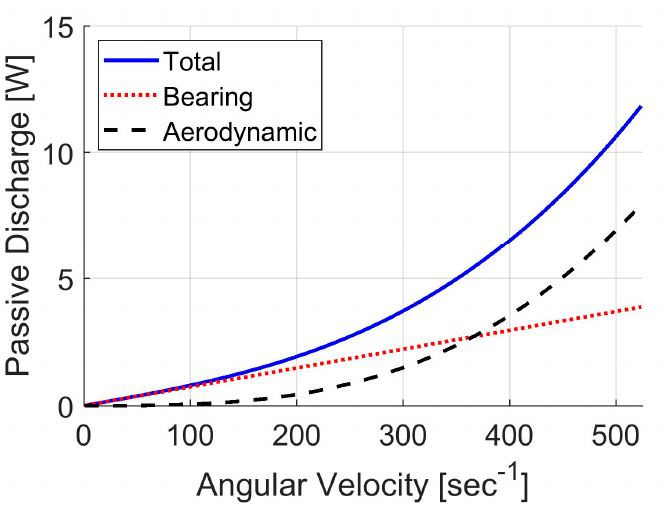
Figure 5. Predictions of the total rotor passive discharge and the components related to aerody ‐ namic and bearing losses for the baseline case (intermediate vacuum